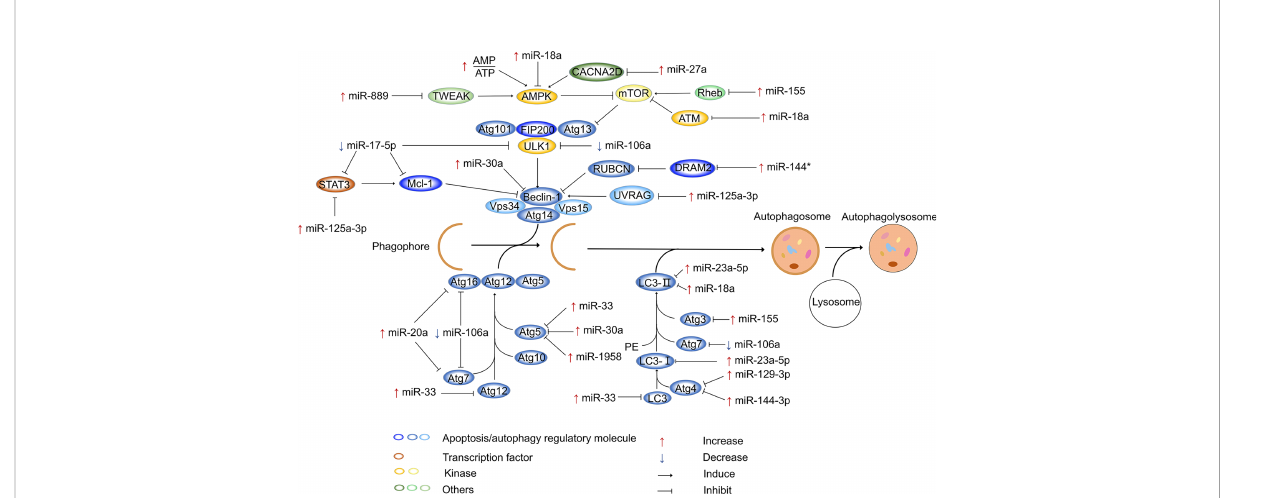
FIGURE 1 miRNAs regulate autophagy after Mtb infection. In the process of autophagy, membrane vesicles encapsulate cytoplasm and organelles to form autophagosomes, which then fuse with lysosomes to form autophagolysosomes. After Mtb infection, miRNAs inhibit or activate autophagy process by modulating ATG genes and other autophagy factors. In this process, various miRNAs are mainly involved in the formation of autophagosomes. The host can defend against the invasion of Mtb by miRNAs. In addition, Mtb also develops strategies to combat autophagy by modulating miRNA expression. “ Increase ” represents the upregulation of miRNAs, “ Decrease ” represents the downregulation of miRNAs. “ Induce ” represents miRNAs promote gene expression, “ Inhibit ” represents miRNAs suppress gene expression , *represents miRNAs ’ passenger